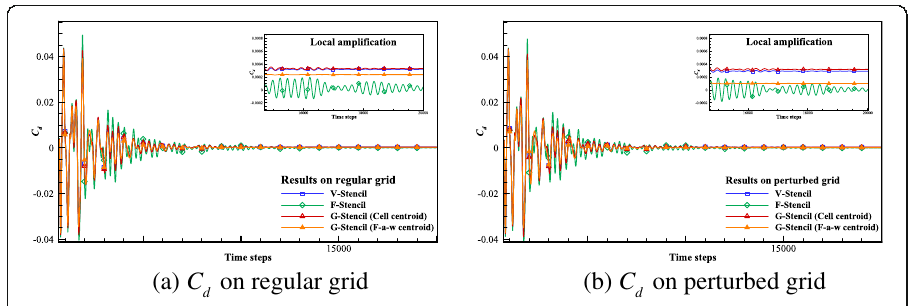
Fig. 27 C d on ( a ) regular and ( b ) perturbed triangular